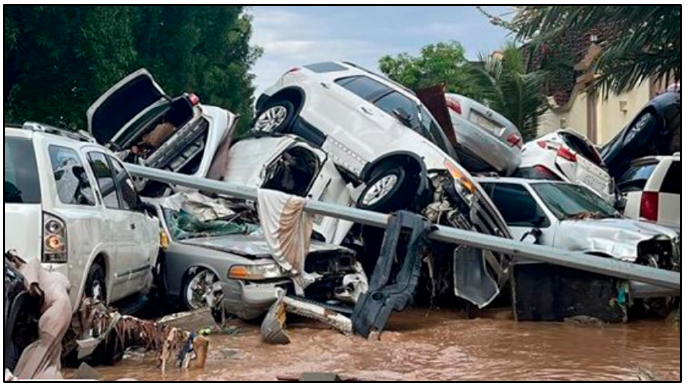
Figure 1. Jeddah floods, 2022.